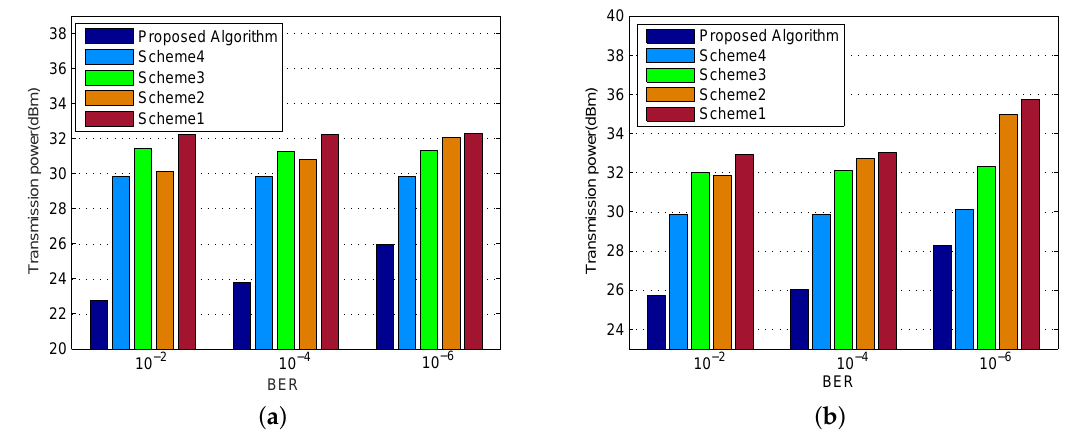
Figure 2. Transmit Power comparison with target BER equaling to 10 − 2 , 10 − 4 and 10 − 6 ( E c = 5 µ W, σ 2 = − 112 dBm). ( a ) K = 8; ( b ) K = 16.